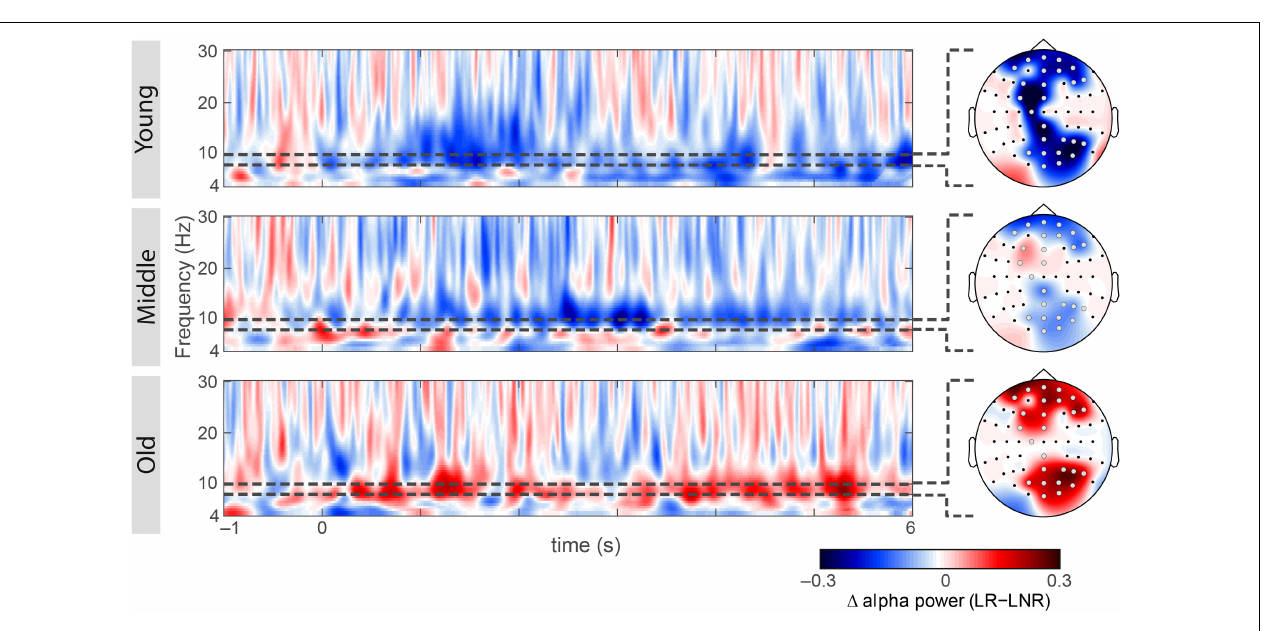
FIGURE 3 | Subsequent memory effect within each age group at electrodes of group-level significance (as shown in Figure 2B ): oscillatory power differences between later-remembered (LR) than for later-not-remembered (LNR) sentences across the theta, alpha and beta frequency range (4–30 Hz) across the minimum sentence length, including the baseline window (–1 to 6 s) for younger, middle-aged and older adults; scalp topographies showing encoding-related lower alpha power differences between LR and LNR (gray electrodes indicate group-level significance). All spectra and topographies were adjusted for the individual alpha